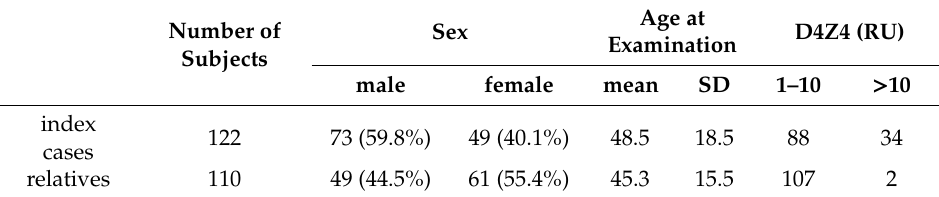
Table 4. Baseline characteristics of selected